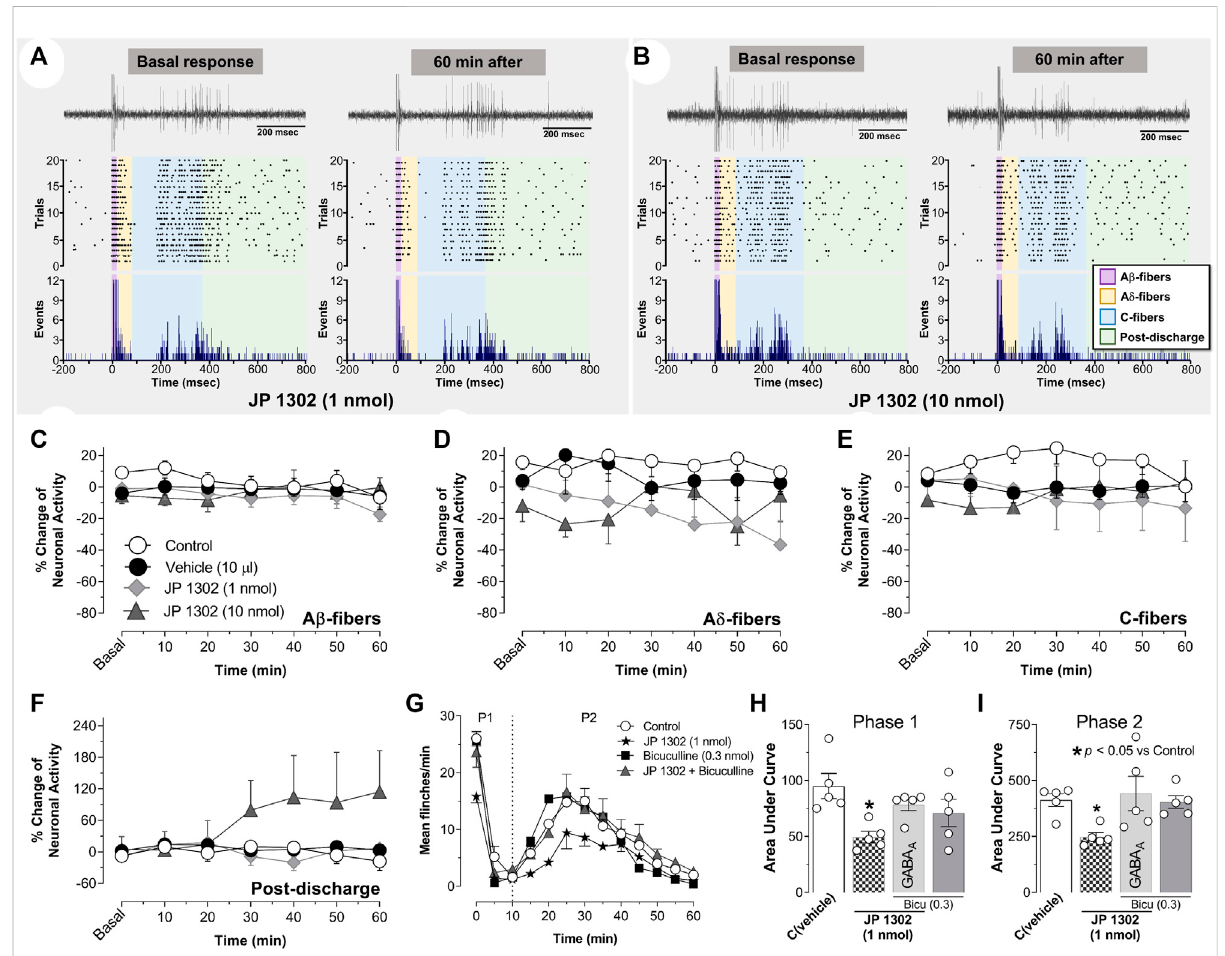
FIGURE 7 SpinalJP-1302 doesnot affectwidedynamicrange (WDR)cellactivity,butbehaviorally,itinhibitsnociceptionbyincreasingGABAergicactivity. (A,B) depict the peri-stimulus time histogram (PSTH) constructed from 20 WDR responses to receptive fi eld (RF) electrical stimulation before (basal) and after treatment (vehicle or JP 1302); also, in these panels, the raster plot and raw tracing of a single second-order WDR neuron cluster response elicited by one electrical stimulus (upper tracing) are illustrated. In accordance with the fi ber conduction velocities, the panels in the fi gure depict thedifferent fi ber components (A β -,A δ -,and C- fi bers) of thespinal WDR cell response. Notethat JP 1302 seems not to exert an effect on the WDR neuronal activity; indeed, when the data are analyzed as a percent of change of the neuronal activity (C – F) , JP 1302 does not impact (statistically) the neuronal fi ring associated with the activation of A β -, A δ -, C- fi bers, and post-discharge. (G) shows the effect of intrathecal